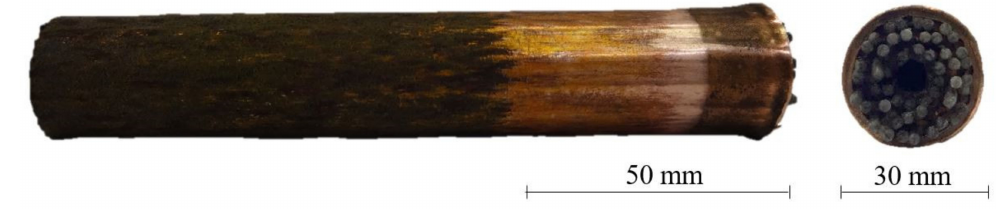
Figure 2. UniPore specimen after the explosive compaction.